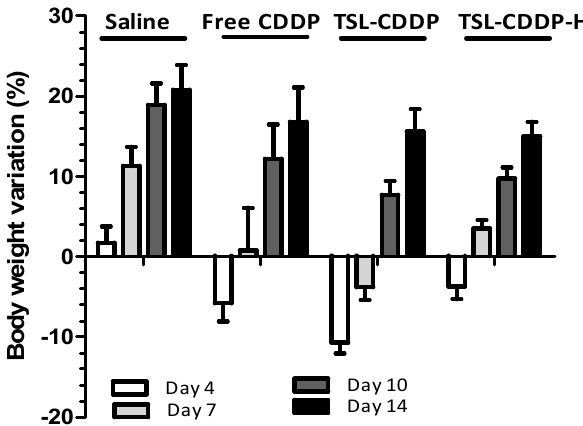
Figure 3. Body weight variation of mice over the 14 days of the experiment. Data were presented as the mean ± standard error of the mean.